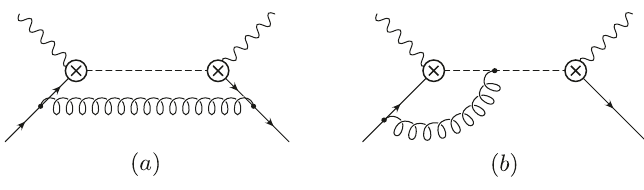
Figure 7 . One loop corrections to the bilocal PDF distribution